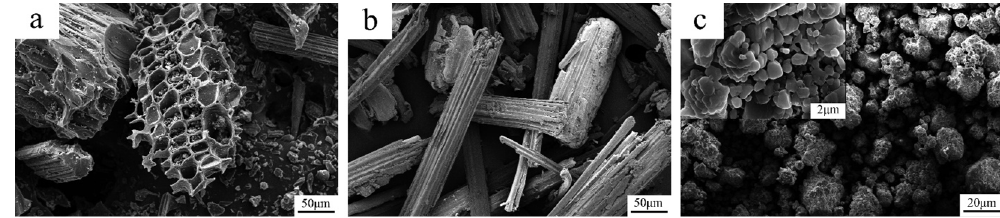
Figure 3. SEM images of ( a ) BC, ( b ) BP and ( c ) AHP.